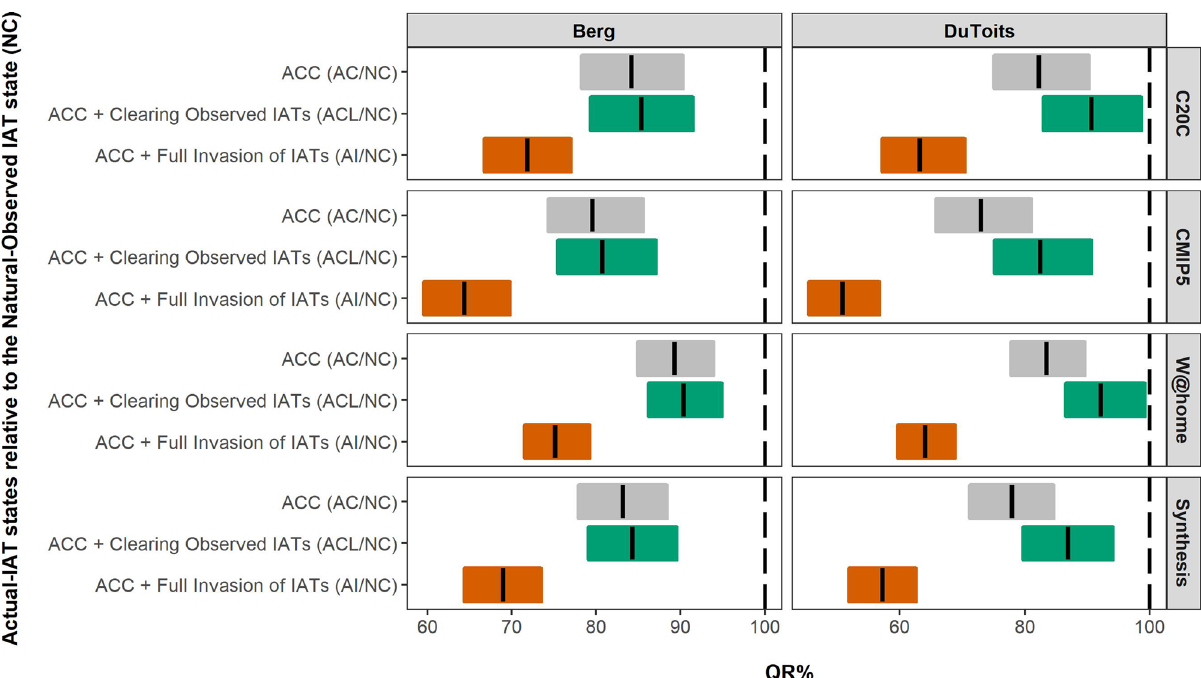
Fig. 4 The percentage of drought-period stream fl ow (QR%) under natural climate realised during the drought period attributable to anthropogenic climate change (ACC) combined with different IAT states. For each catchment (Berg and Du Toits, South Africa), the percentage reference state (Natural Current) drought-period stream fl ow is shown for each comparator state (Actual Current, -Cleared, -Invaded) (also see Supplementary Table 1). Changes are shown for each climate model experiment (C20C, CMIP5 and W@home) and for the multi-model experiment synthesis (Synthesis). The solid line is the median change, while the coloured bar shows the 95% con fi dence interval (Methods and Supplementary Methods 1). NC Natural Current, AC Actual Current, ACL Actual Cleared, AI Actual Invaded.